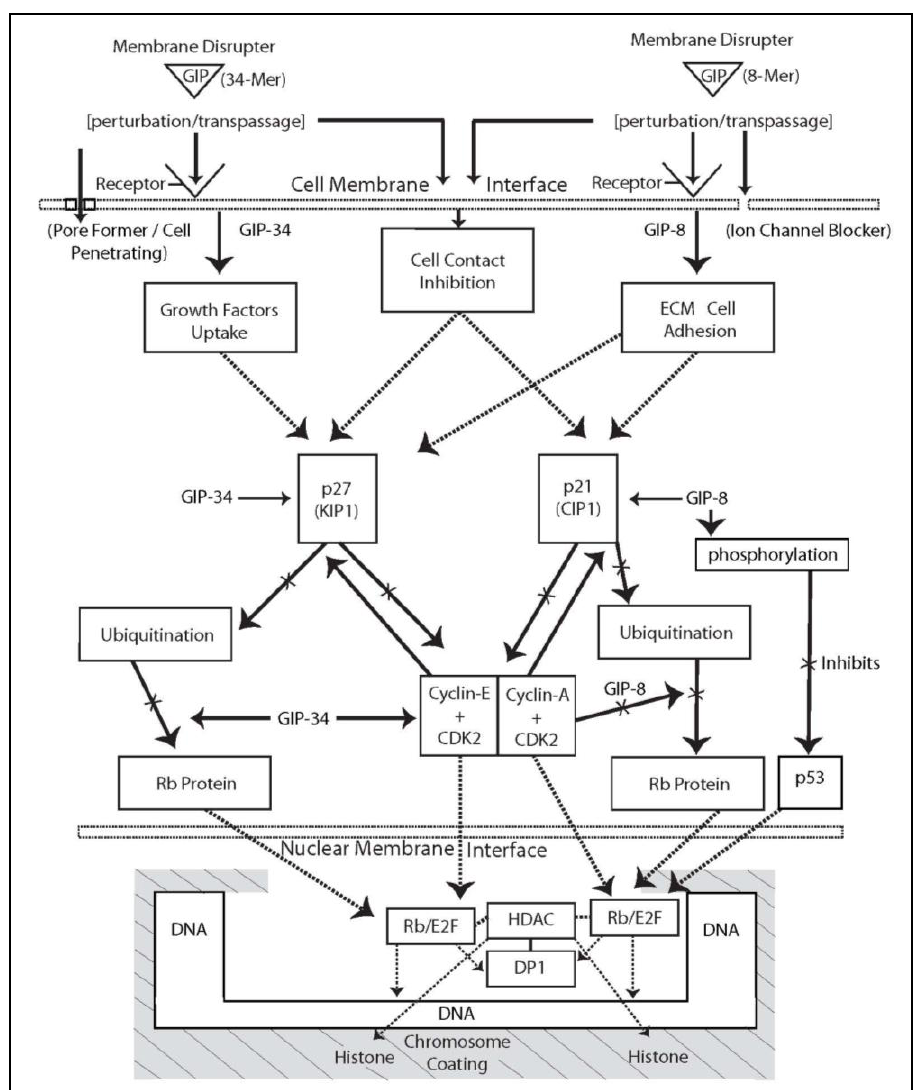
Figure 3. A flow diagram showing the proposed mechanism of growth inhibition of cancer cells by GIP-34 (left side) and GIP-8 (right side). Solid black-line arrows indicate pathways verified by direct evidence; the dash-line arrows represent hypothetical, proposed, or published